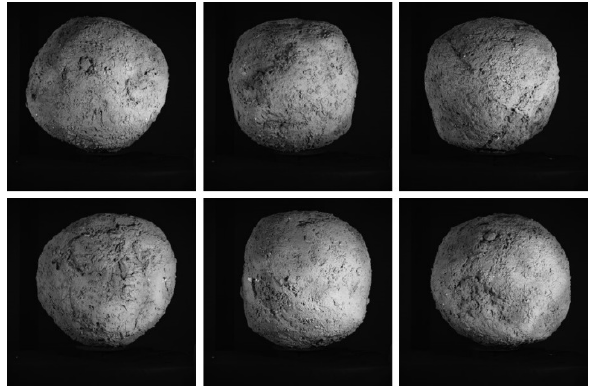
Figure 6. Example images captured by the camera Based on these images, we completed the 3D reconstruction of the simulated asteroid through the processes shown in Figure 2 and Figure 3, resulting in the 3D point cloud of simulated asteroid. Figure 7 shows the dense point cloud and the textured model of 3D reconstruction